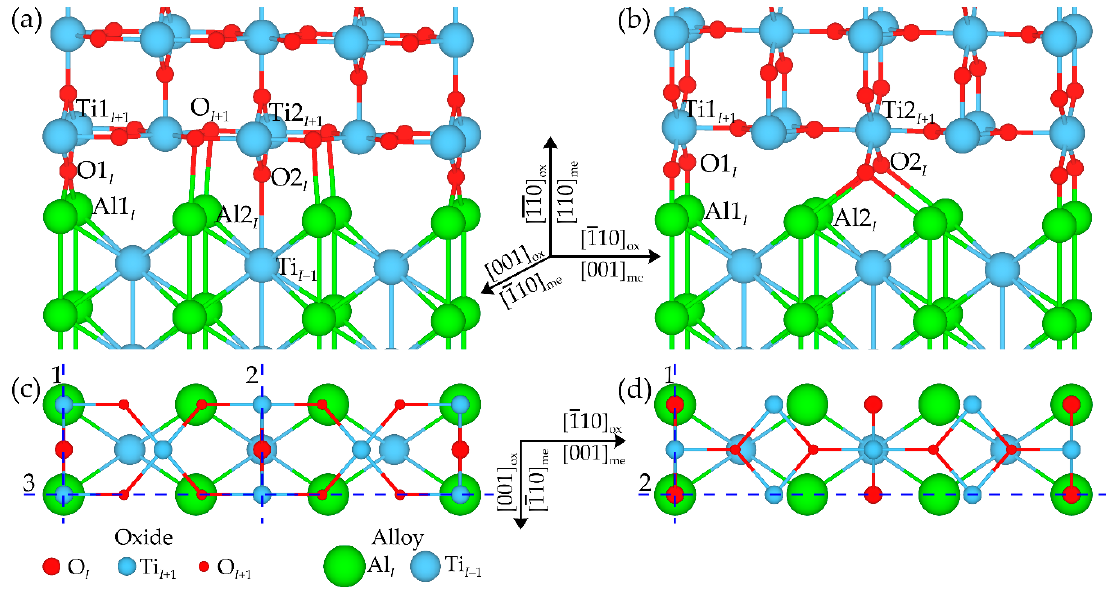
Figure 3. Atomic structures of unrelaxed interfaces with ( a , c ) hollow and ( b , d ) top configuration. Atoms that are important in interfacial bonding are marked. Symbols I and I ± 1 denote atoms of interfacial and subinterfacial layers.